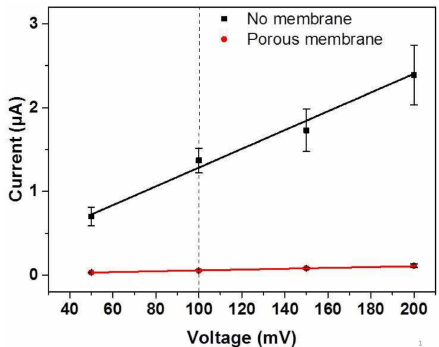
Figure 5. Current/voltage characteristics of an aqueous SPP buffer solution for the different setups described in the text. The dashed line marks the voltage used for the electrophoresis-driven disc insertion at 100 mV. Besides the mean values of the currents, the standard deviations and the linear regressions are shown in the